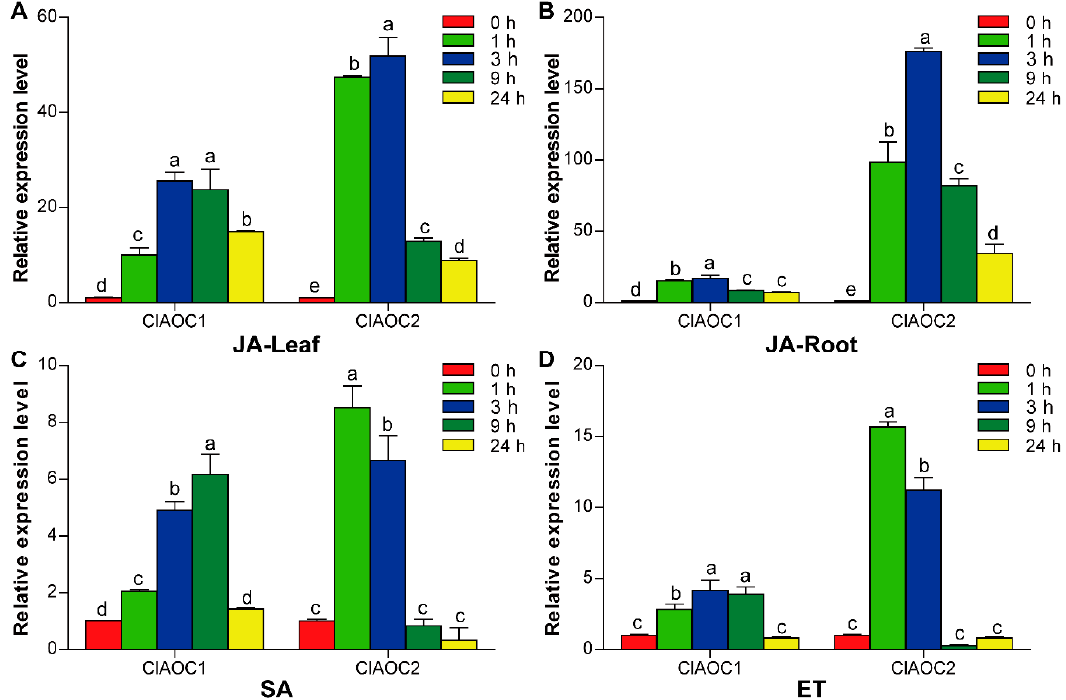
Figure 7. qRT-PCR analysis of ClAOC1 and ClAOC2 under different hormones treatments, including JA ( A , B ), SA ( C ), and ET ( D ). The leaves ( A , C , D ) or roots ( B ) of the watermelon seedlings were used to examine the expression levels of ClAOC1 and ClAOC2 using qRT-PCR at different time points (0,